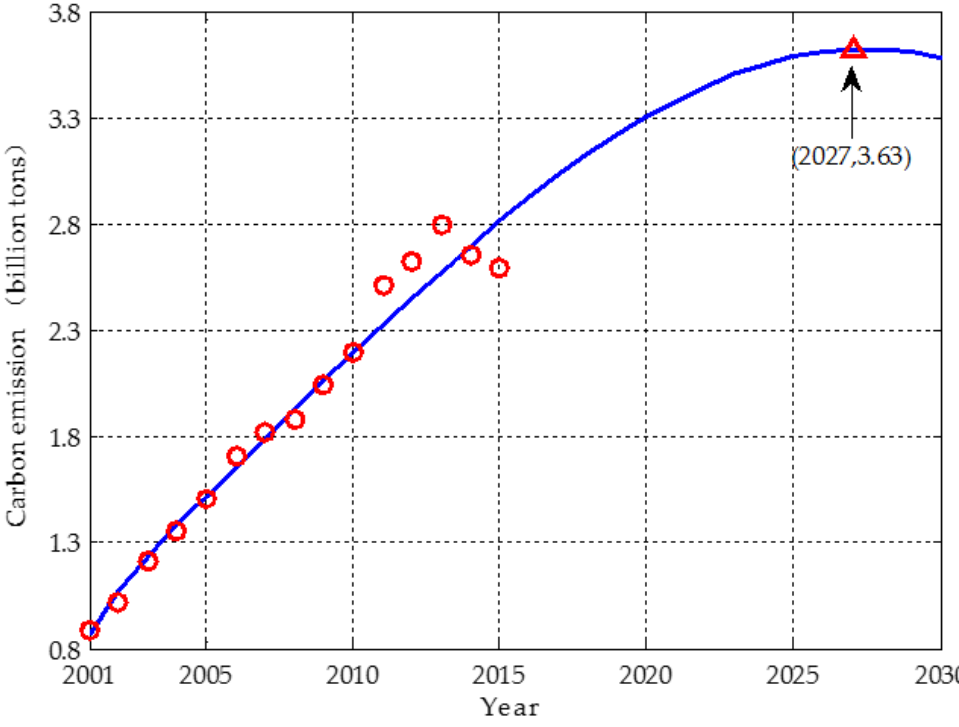
Figure 2. Fitting and forecasting results for the carbon emissions in the electric power industry.